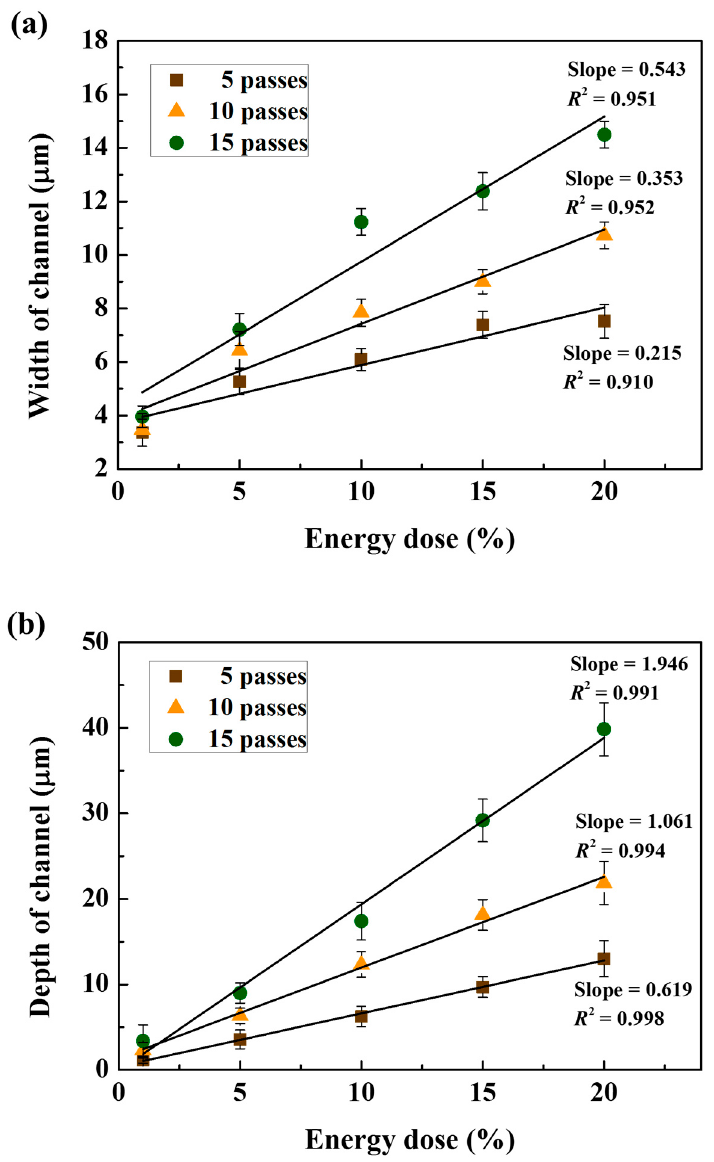
Figure 3. Characterization of the ( a ) depth and ( b ) width of the femtosecond laser micro-scribed channels.